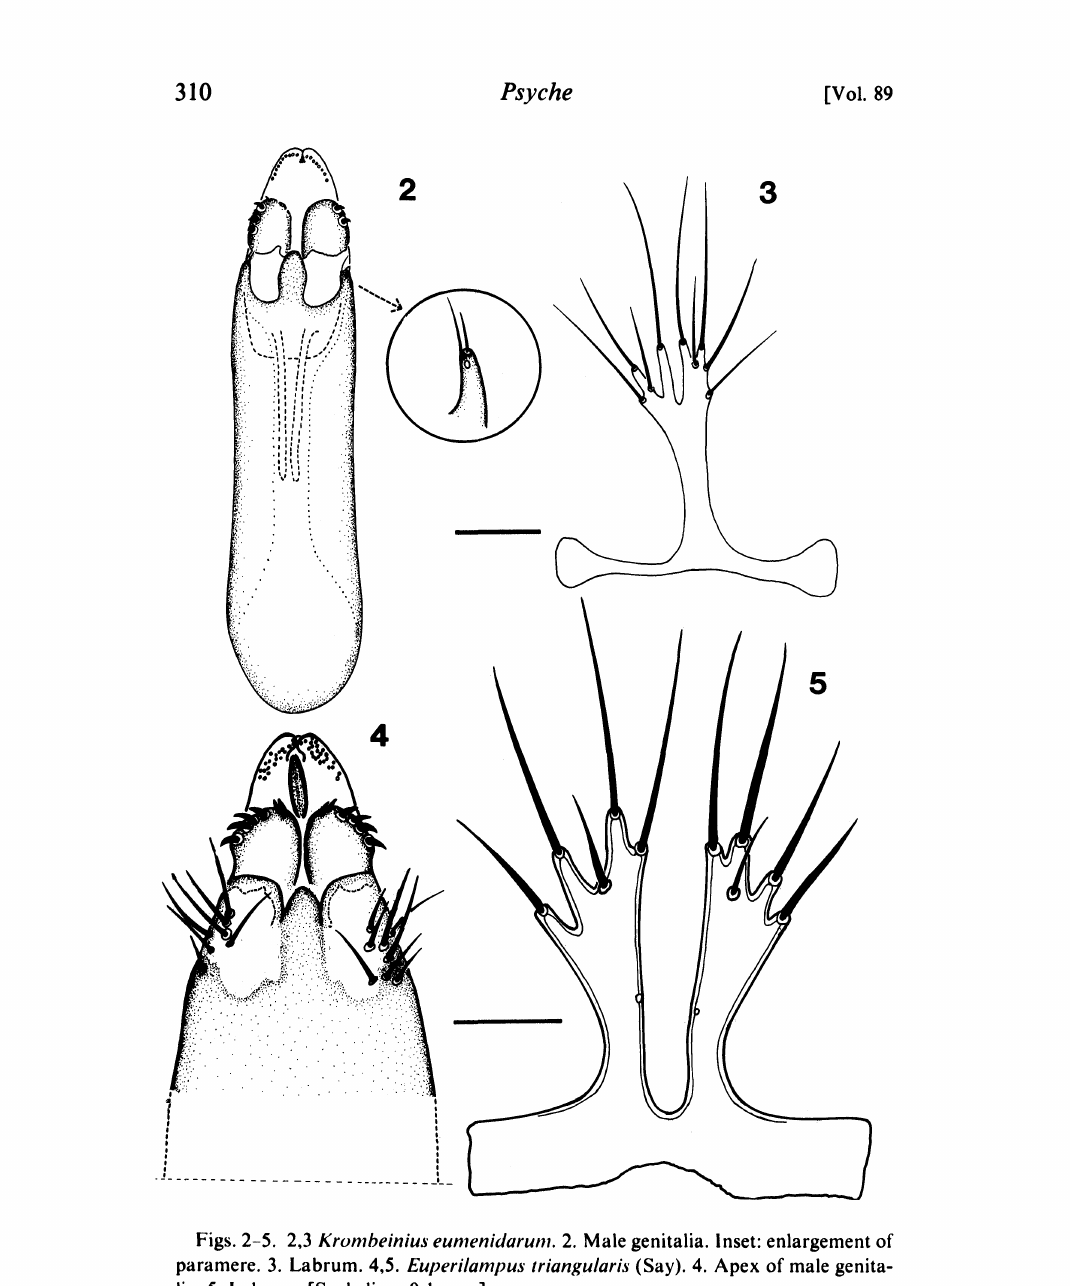
Figs. 2-5. 2,3 Krombeinius eumenidarum. 2. Male genitalia, inset: enlargement of paramere. 3. Labrum. 4,5. Euperilampus Iriangularis (Say). 4. Apex of male genita- lia. 5. Labrum. [Scale lines 0.1